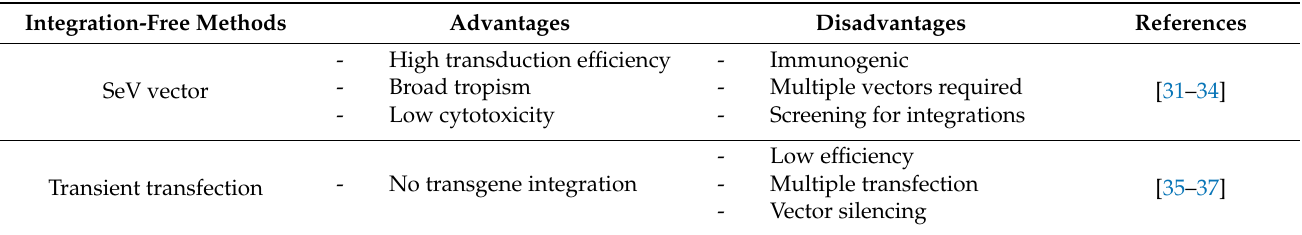
Table 4. The advantages and disadvantages of integration-free methods. Integration-Free